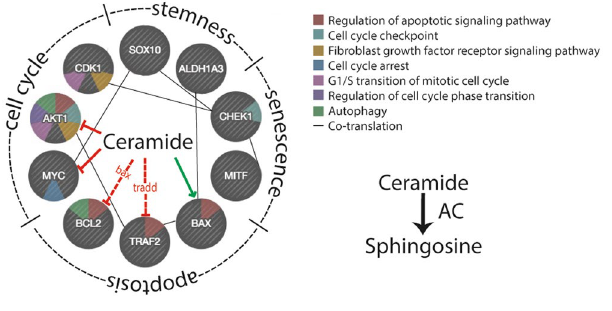
Figure 10. Regulation of cell fate by ceramide. Hypothetic model showing potential interactions of ceramide with various factors involved in cell cycle, stemness, senescence and